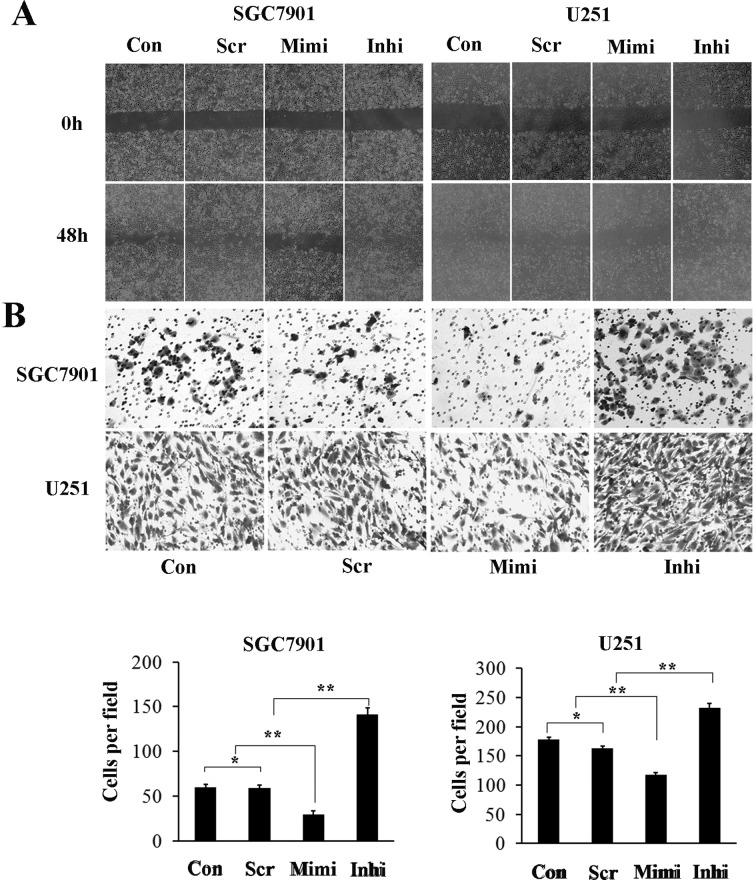
miR-200a affects migration and invasion of the tumor cells. Measurement of cell migration by ‘wound-healing’ assay and Transwell assay. Transient over-expression of miR-200a inhibited the migration of SGC7901 and U251 cells. Data shown are the mean and standard deviation from analyzing three fields per sample in triplicate (*p>0.05, **p<0.05).